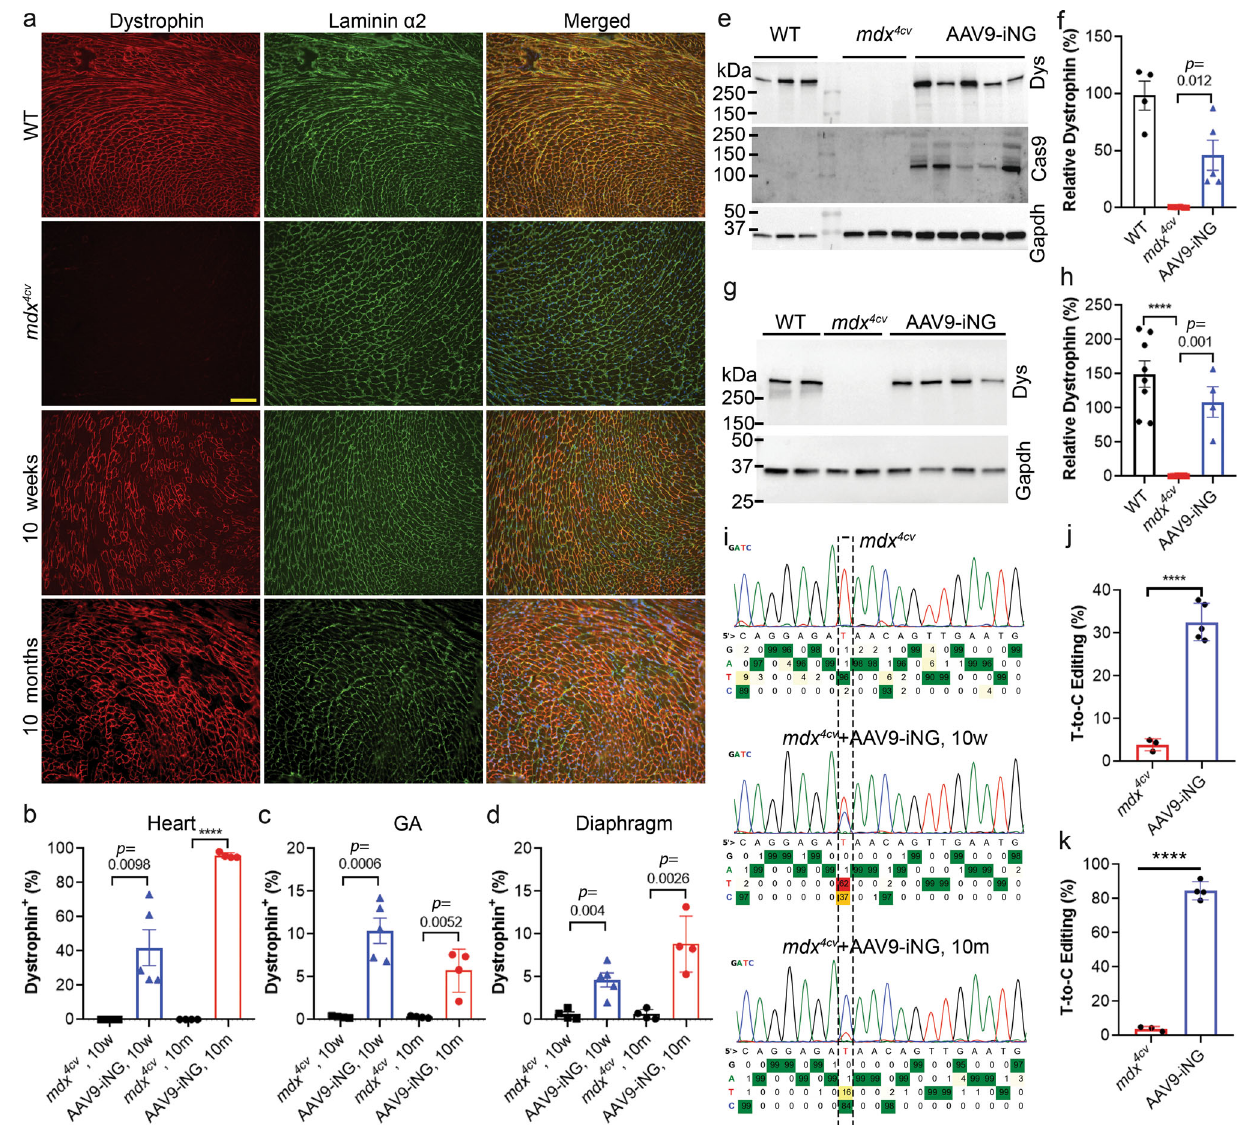
Fig. 5 Widespread restoration of dystrophin expression in mdx 4cv mice following systemic administration of AAV9-iNG. a Dystrophin and laminin- α 2 co-immunostaining of heart sections from WT and mdx 4cv mice (10 weeks or 10 months of age) with or without tail vein injection of AAV9-iNG (a total of 1 × 10 14 vg/kg, 1:1 of the N and C-terminal half). Scale bar: 100 µ m. b – d Quanti fi cation of dystrophin-positive fi bers in the heart ( b ), gastrocnemius (GA, c ) and diaphragm (Diaph, d ) muscles. 10w, 10 weeks old ( n = 4 mdx 4cv and 5 AAV9-iNG treated mice); 10 m, 10 months old ( n = 4 mice /group); **** p < 0.0001; two-tailed unpaired t test. Da t a are mean ± s.e.m. e Western blot analysis of heart homogenates from 10-week-old mice with anti-dystrophin, Cas9 and Gapdh antibodies. The WT muscle lysates were loaded at 5 µ g/lane while the mdx 4cv muscle lysates were loaded at 25 µ g/lane. The samples were derived from the same experiment and the gels/blots were processed in parallel. f Densitometry quanti fi cation of Western blot data shown in ( e ). n = 4, 6 and 5 mice for WT, mdx 4cv and AAV9-iNG groups, respectively; one-way ANOVA with Turkey ’ s multiple comparisons test. Data are mean ± s.e.m. g Western blot analysis of heart homogenates from 10-month-old mice with anti-dystrophin and Gapdh antibodies. h Densitometry quanti fi cation of Western blot data in ( g ). n = 8, 8 and 4 mice for WT, mdx 4cv and AAV9-iNG groups, respectively; **** p < 0.0001; one-way ANOVA with Turkey ’ s multiple comparisons test. Data are mean ± s.e.m. i Representative sequencing trace of dystrophin transcripts of WT and mdx 4c v mouse hearts (10 weeks or 10 months old) with or without AAV9-iNG treatment. j , k Quanti fi cation of the targeted T-to-C editing ef fi ciency in the mdx 4cv mouse hearts ( j , 10 weeks; k , 10 months) as assayed by sequencing of dystrophin transcripts. n = 3 mdx 4cv , 5 AAV9-iNG 10 weeks and 4 AAV9-iNG 10 months; **** p < 0.0001; two- tailed unpaired t test. Data are mean ±